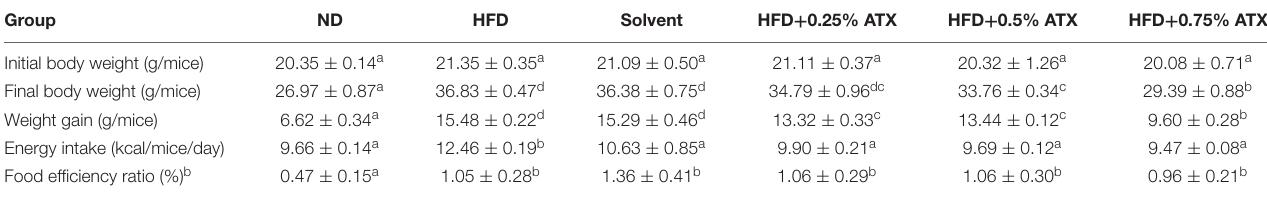
TABLE 1 | Effect of astaxanthin (ATX) supplementation on body weight, energy intake, and food efficiency ratio in high-fat diet-induced mice a . Group